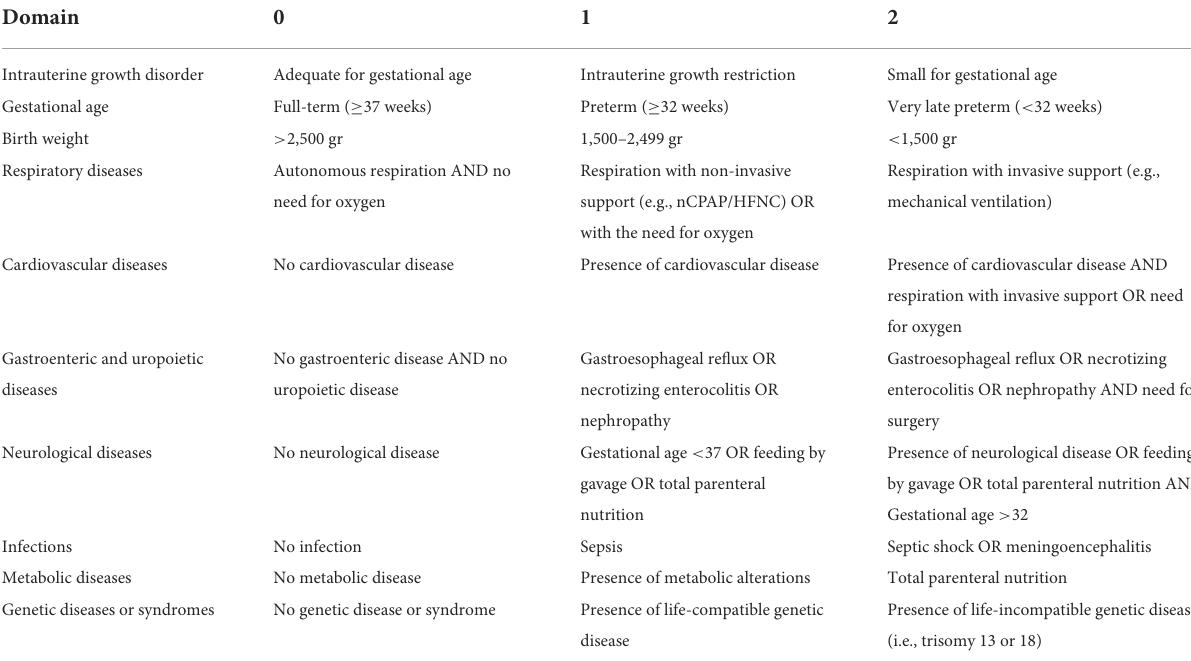
TABLE 2 Complexity index